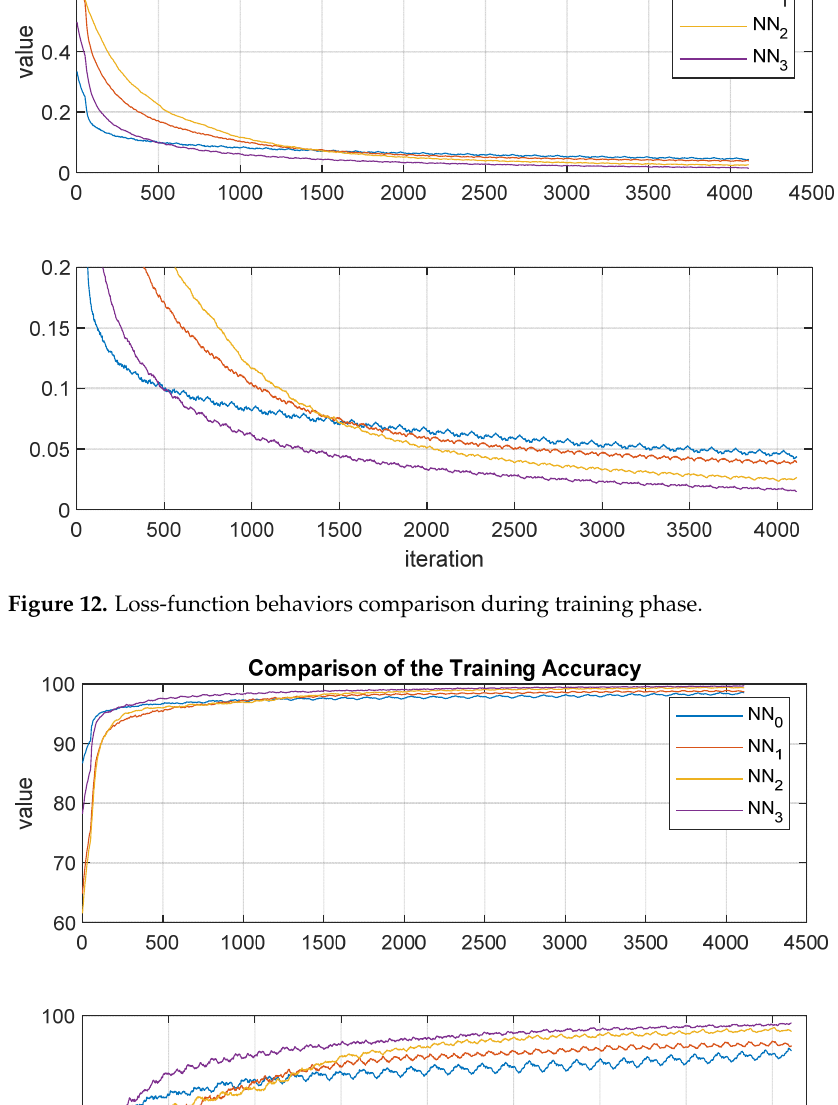
Figure 11. Different artificial neural networks compared.